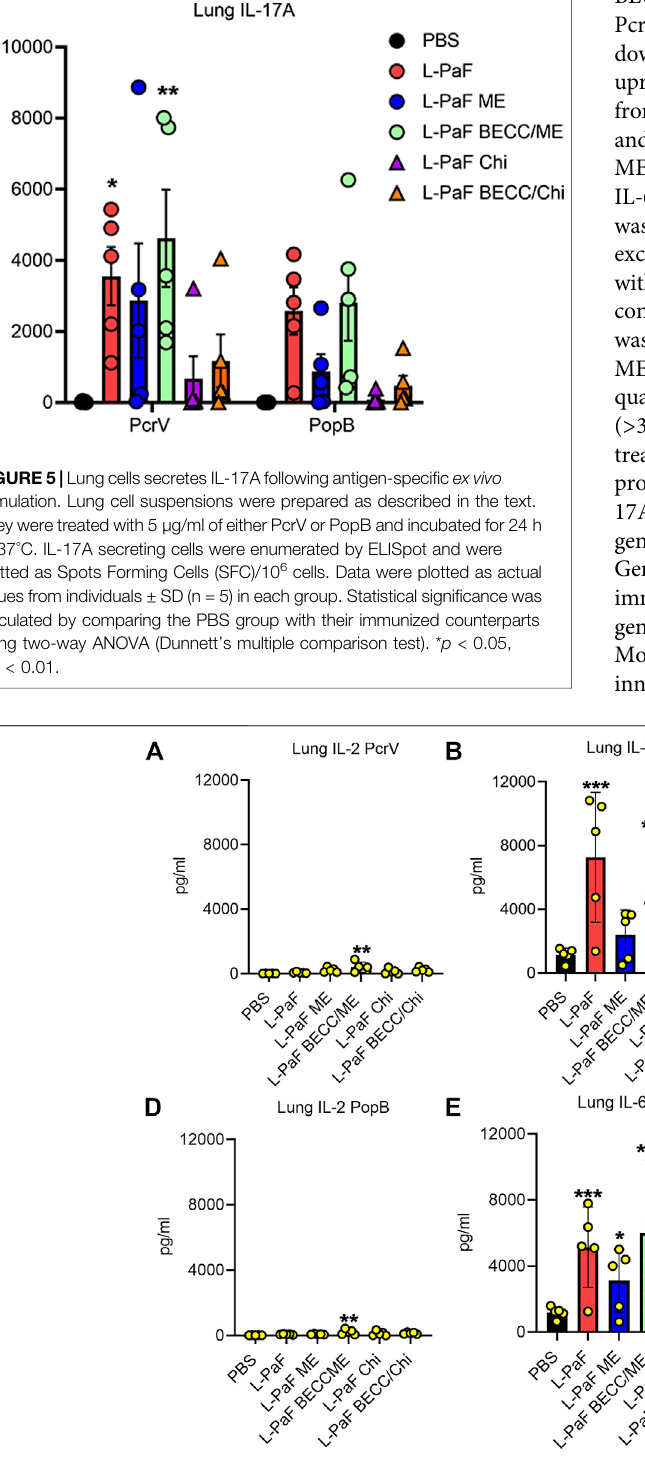
Frontiers in Pharmacology |